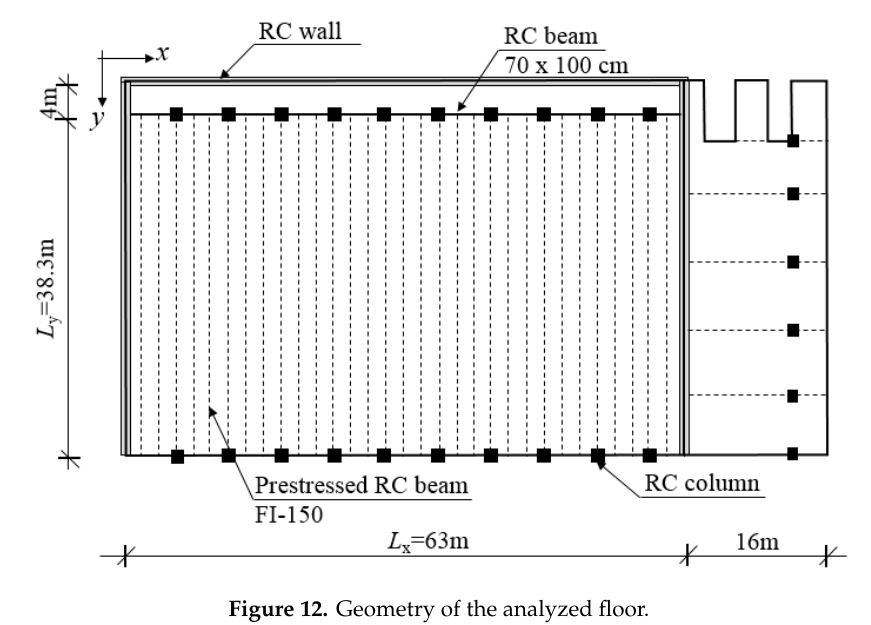
Figure 12. Geometry of the analyzed floor.